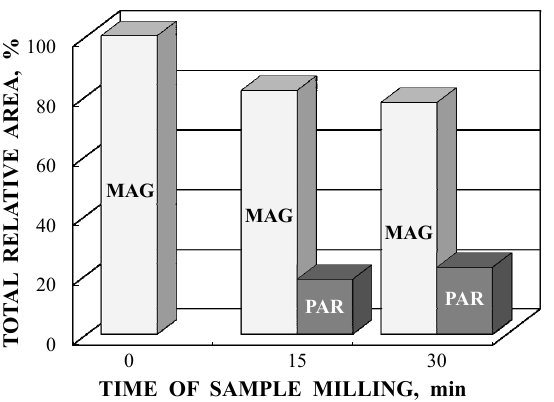
Figure 59. The change in the total relative area of magnetic (MAG) and paramagnetic (PAR) com‑ ponents in the Mössbauer spectra of NiFe 2 O 4 samples N1, N2 and N2 with increase in milling time. Adapted from Ref. [83] with permission from Springer Nature: Hyperfine Interactions, “The milling effect on nickel ferrite particles studied using magnetization measurements and Mössbauer spec‑ troscopy”, Ushakov M.V., Oshtrakh M.I., Chukin A.V., Šepel á k V., Felner I., Semionkin V.A.,